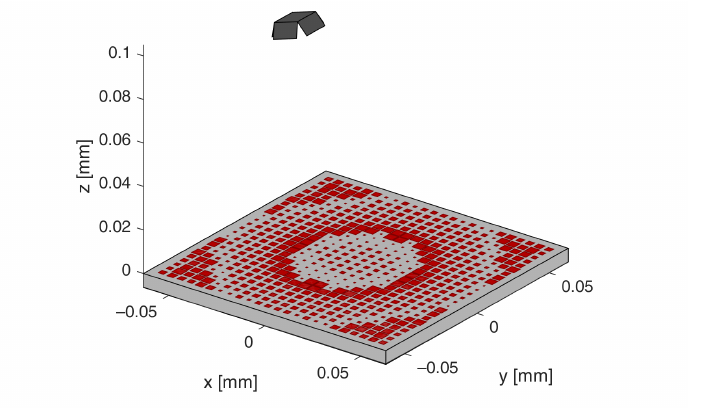
Figure 1. Geometry of the planar reflectarray antenna: feeder (upper dark red horn antenna) and the reflector with in red the all